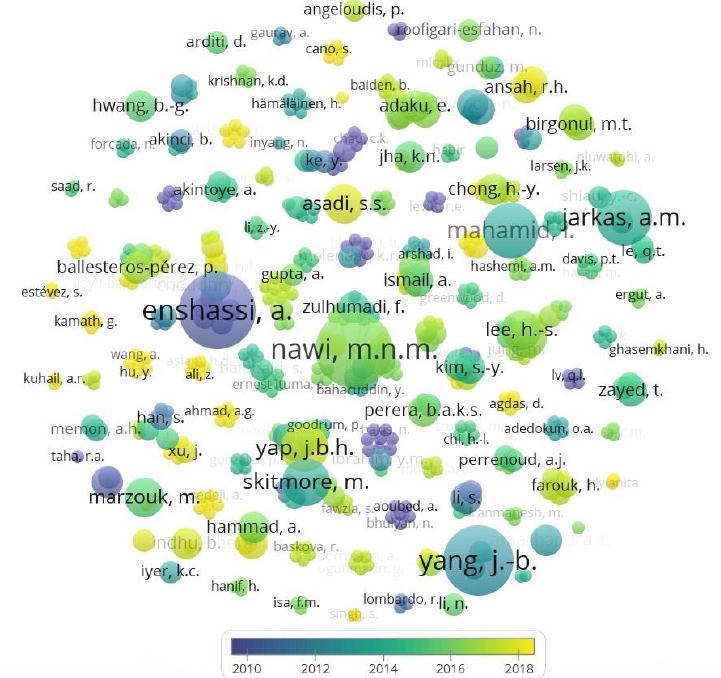
Figure 1. Visualisation of co-authorship network for all 1179 co-authors using the full counting method based on the first bibliographic dataset including 493 papers.